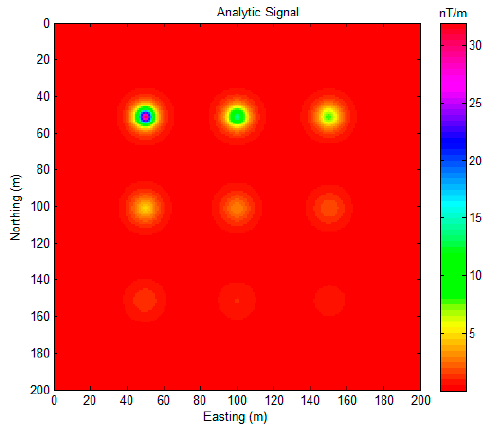
Figure 5. Total field anomalies of the synthetic model.